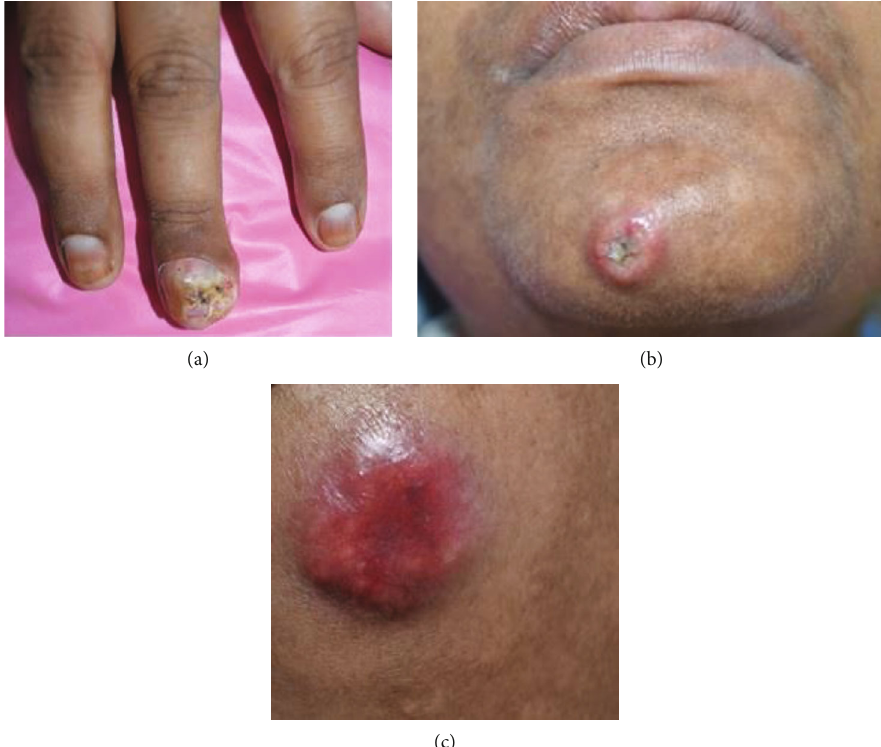
Figure 2: (a) Distal phalanx lesion on the third digit of the right hand. (b) and (c) Lesion with central necrotic crust involving the chin and forearm.